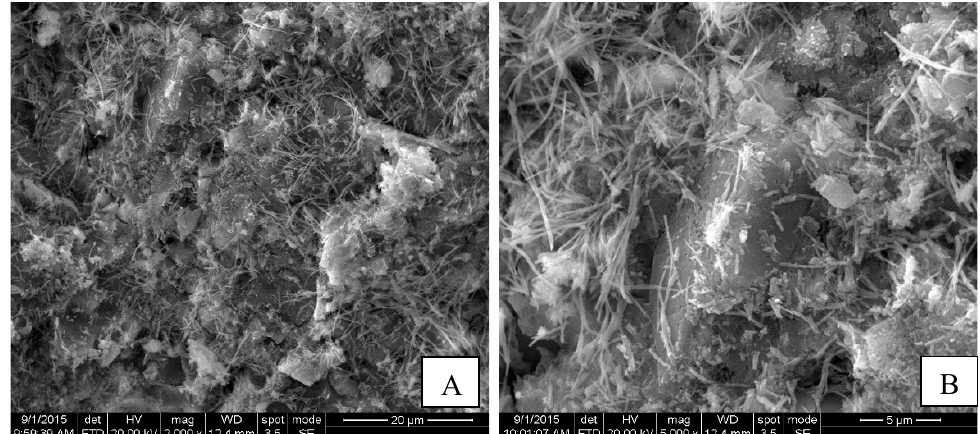
Figure 21. SEM images of 7-day-cured sample containing 10% CRCF: ( A ) 2000 × ; ( B ) 5000 × .